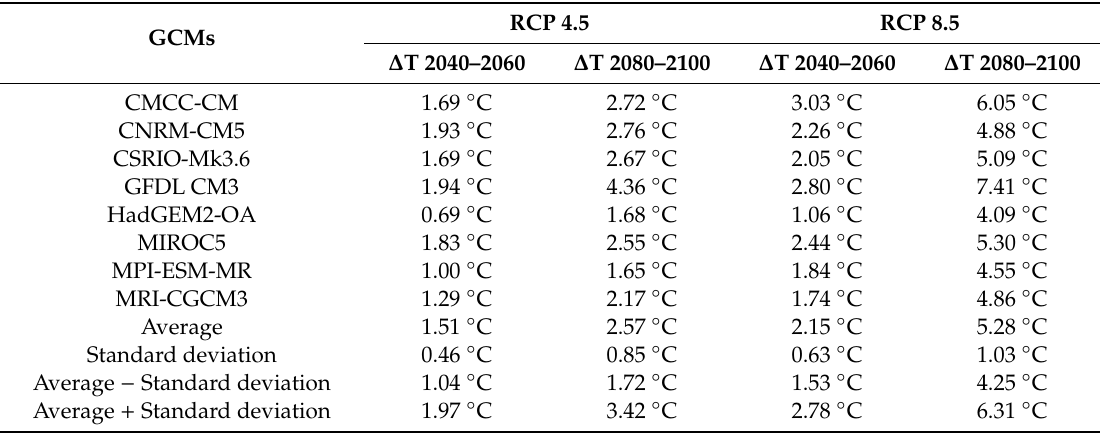
Table 3. Determination of lower and higher temperatures rise under each RCP from the eight